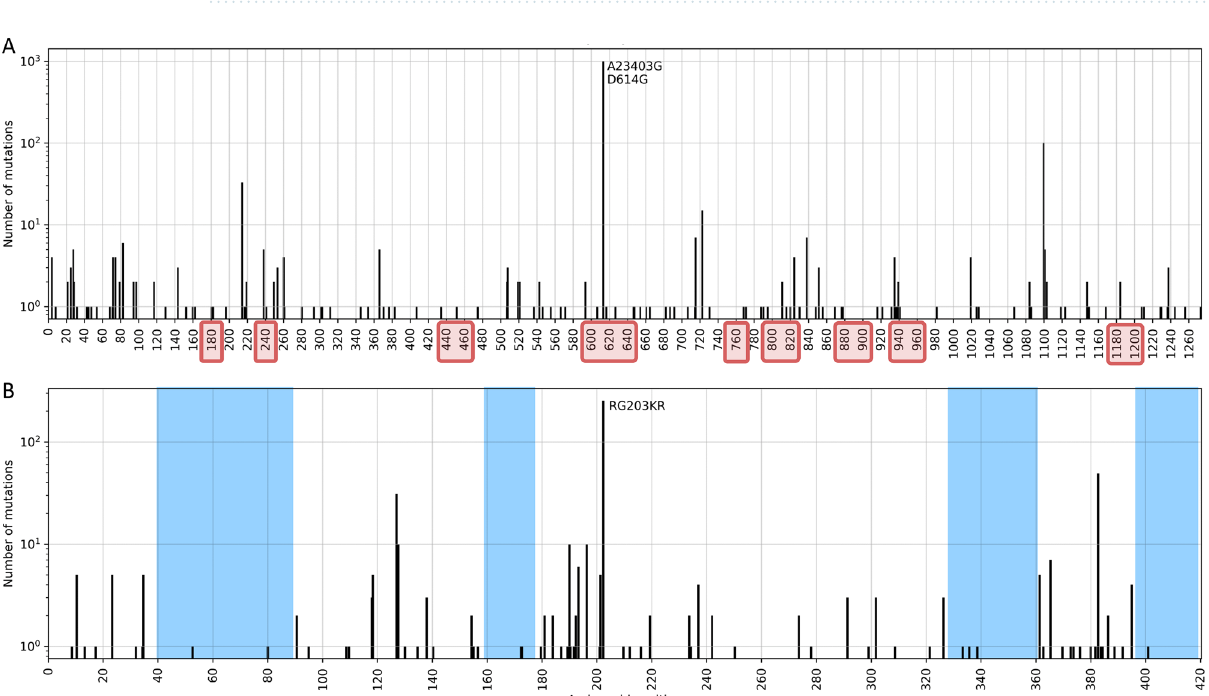
Figure 4. Total number of nucleotide mutations in the S ( A ) and N ( B ) proteins in samples from the Netherlands are displayed on y-axis; predicted epitope regions from 38 are shown with red rectangles on x-axis, and conserved sites (free of mutations) on N protein are shaded in blue in ( B ). X-axis tick marks are labelled with the corresponding amino-acid position to complement the mutation